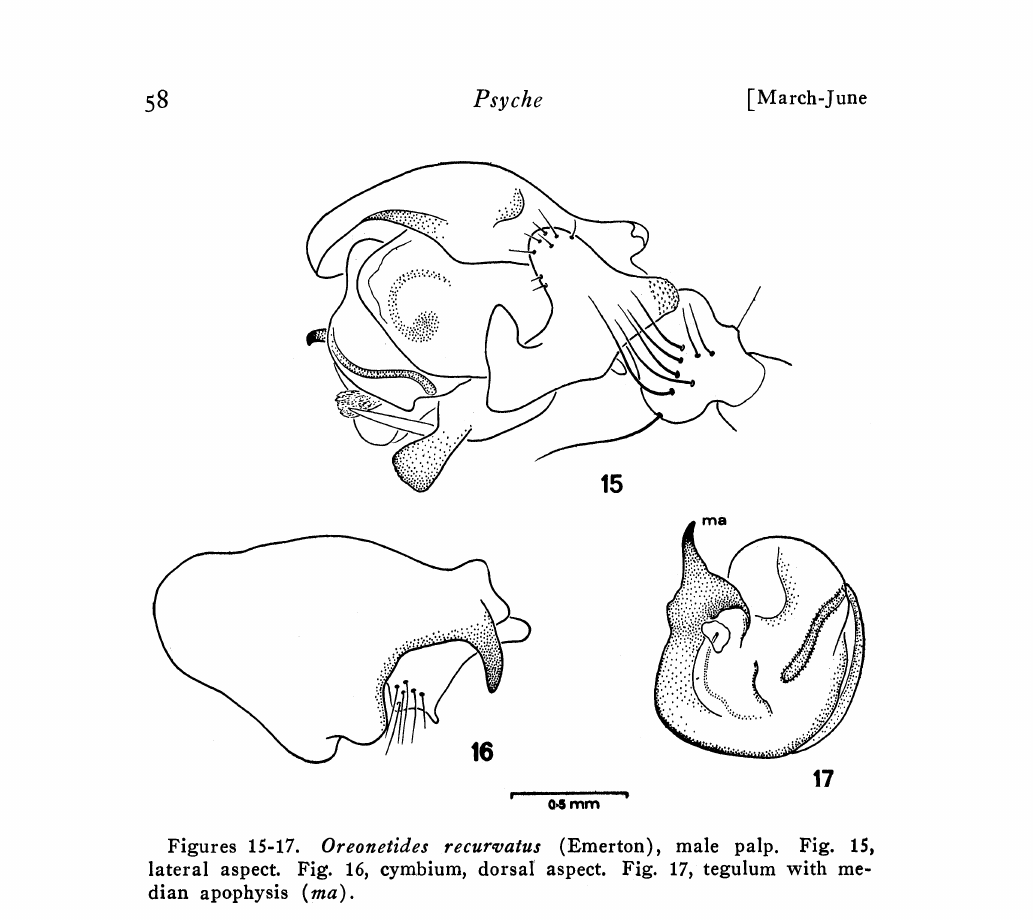
Figures 15-17. Oreonetides recuratus (Emerton), male palp. Fig. 15, lateral aspect. Fig. 16, cymbium, dorsaI aspect. Fig. 17, tegulum with me- dian apophysis